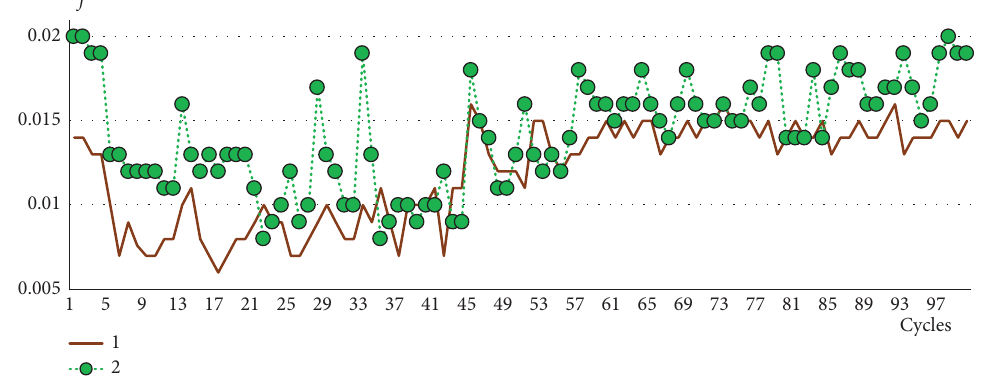
Figure 4: Kinetics of change in the friction coefcient: 1: sample 1; 2: sample 2.